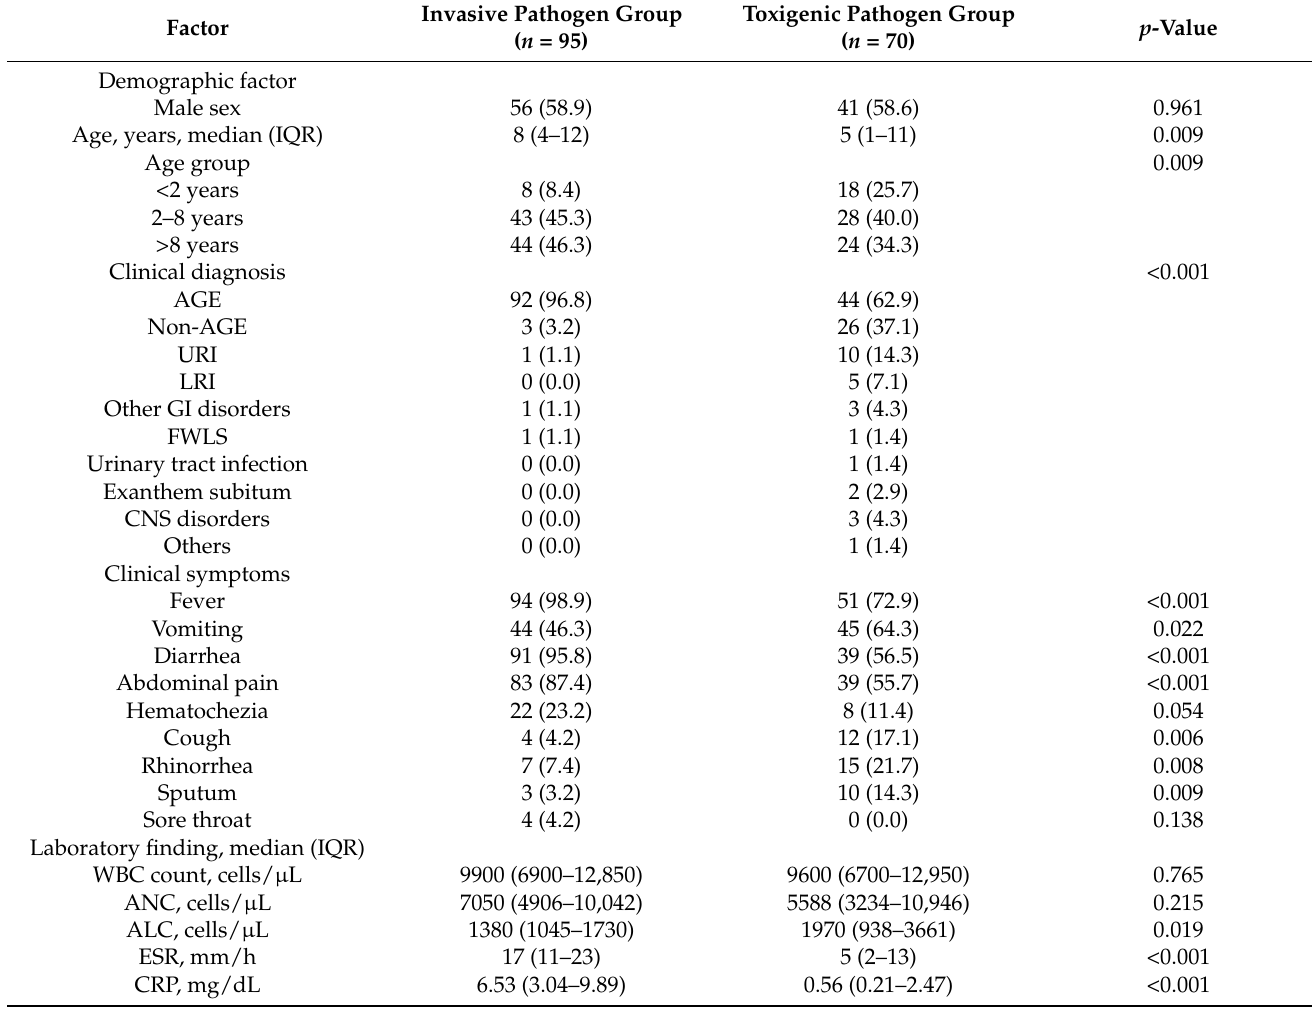
Table 4. Comparison between the invasive pathogen and toxigenic pathogen